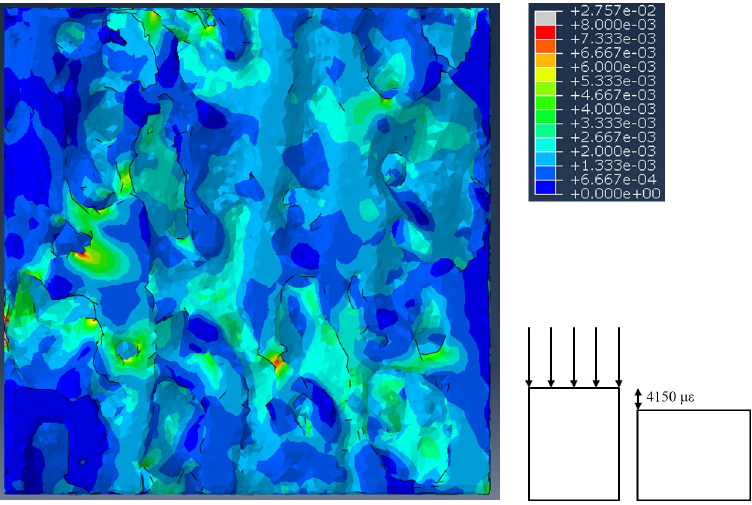
Fig 2. Example finite element model after compression to a macroscopic strain of 4,150 microstrain ( μ ε ). The color gradient corresponds to the max principal strain in each element.